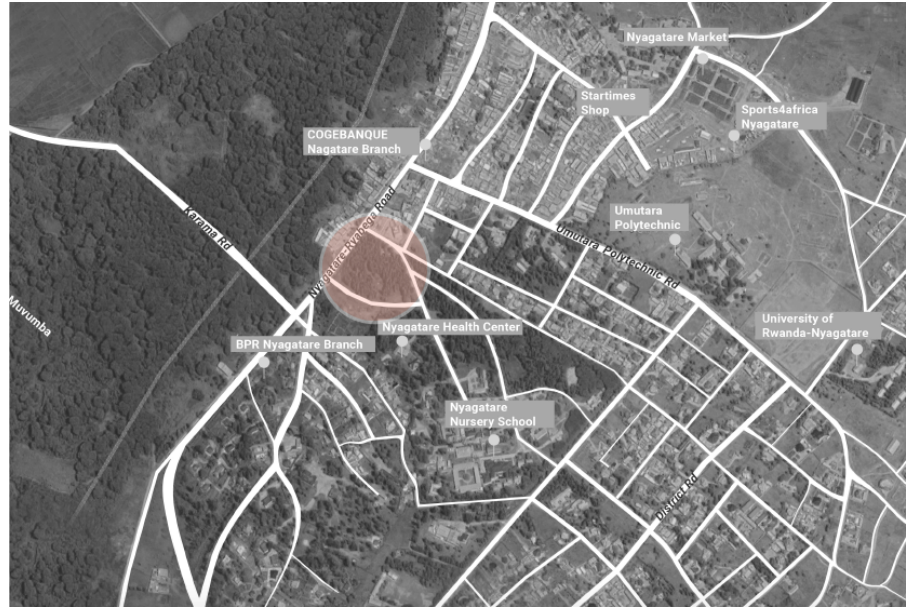
Figure 5. Location of public space within the city of